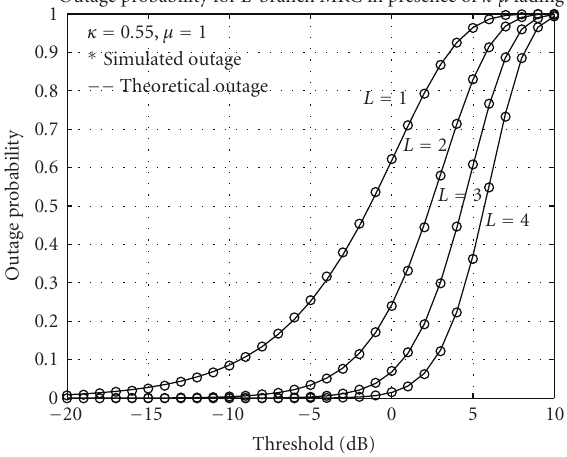
Figure 1: Outage probability for κ = 0 . 55 and μ = 1.